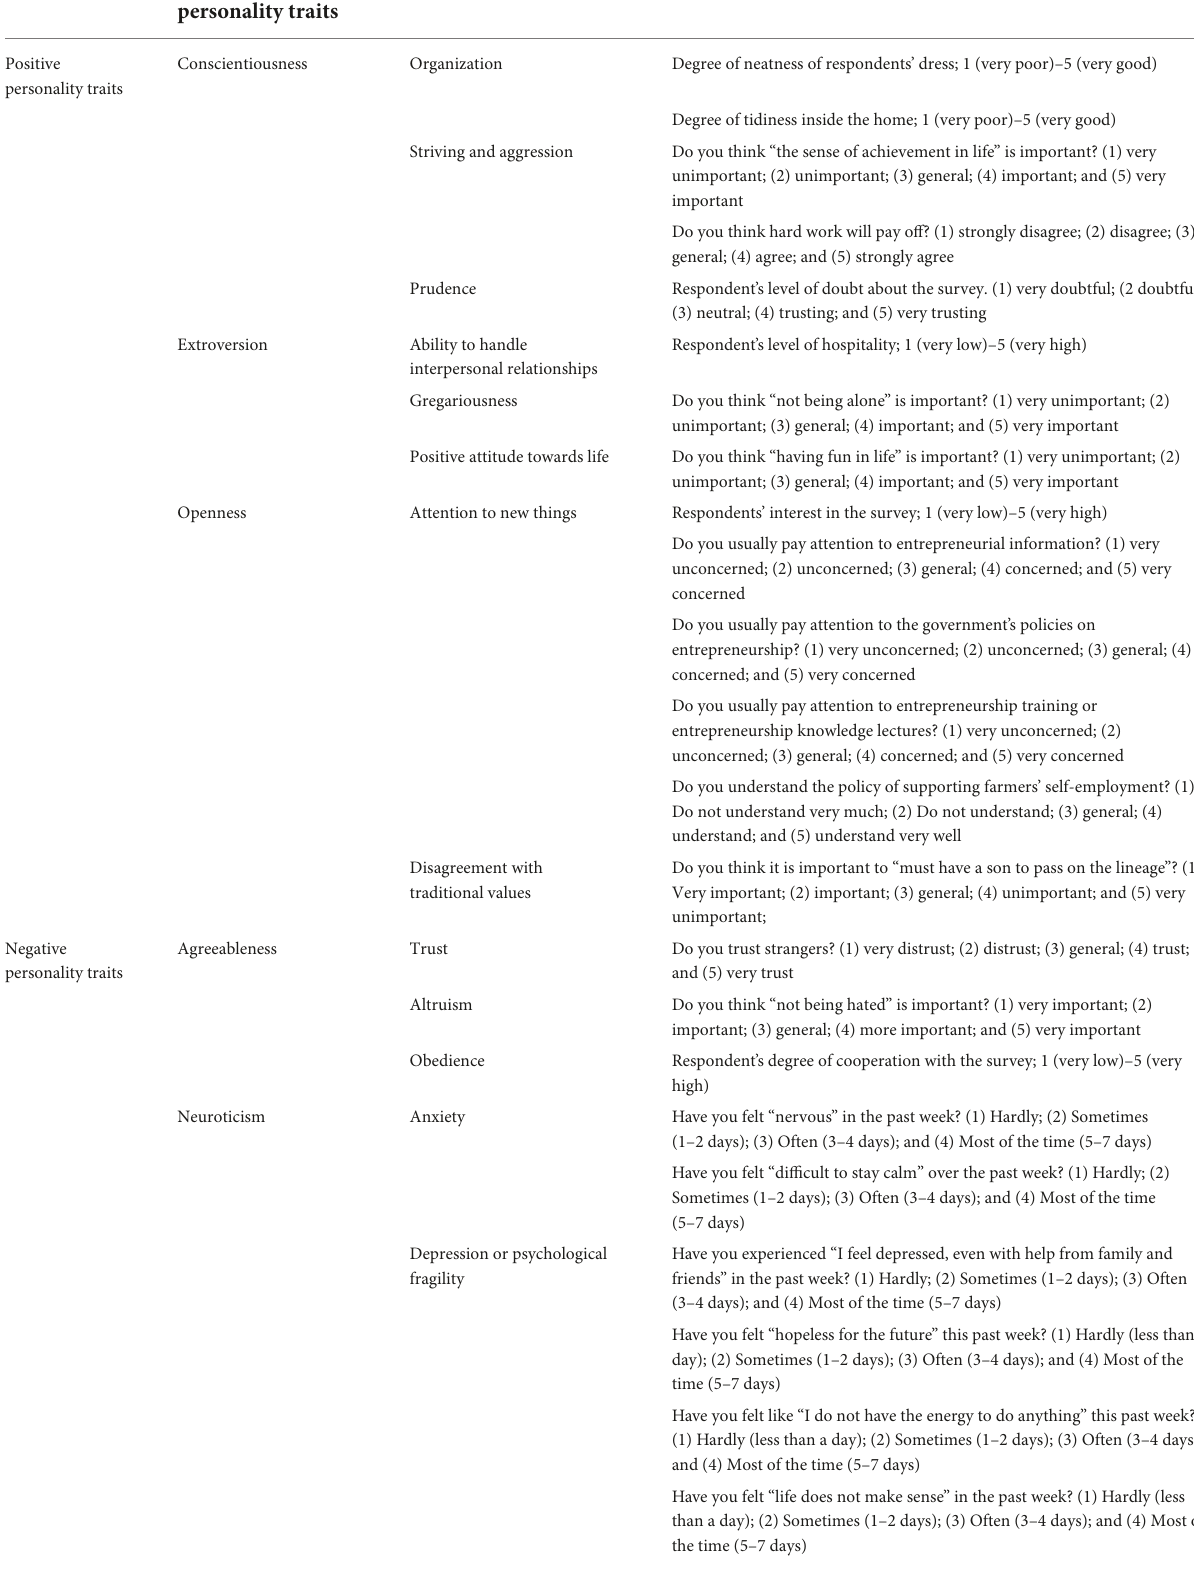
TABLE 4 Big Five personality characteristic classification and corresponding